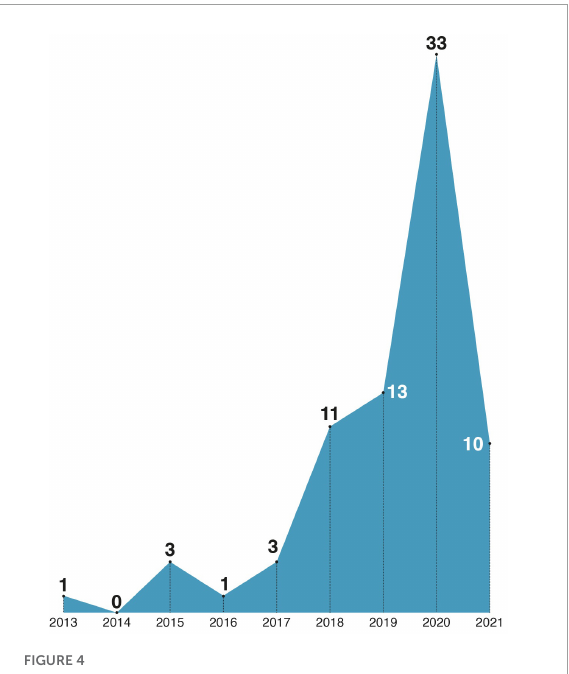
FIGURE4 Social media misinformation year of publications distribution in the